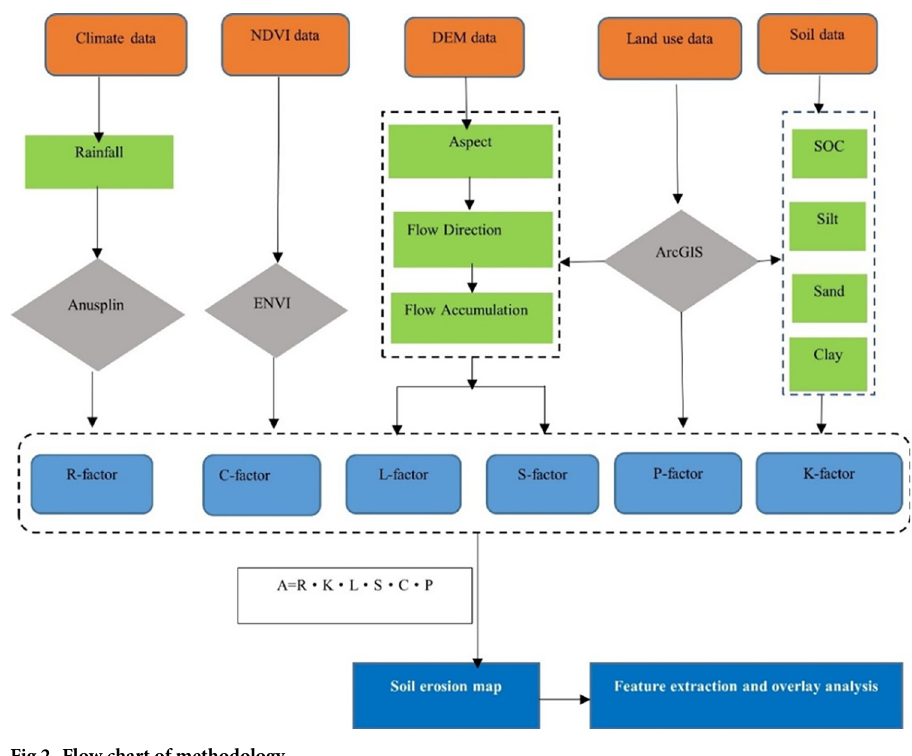
Fig 2. Flow chart of